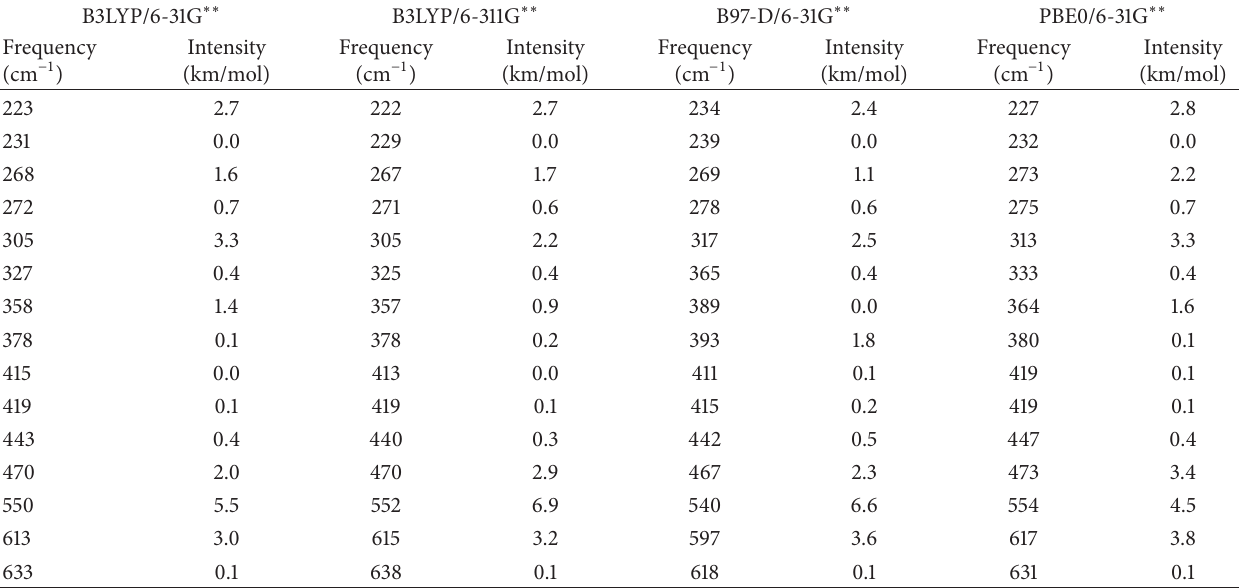
Table 3: Unscaled calculated frequency and intensity of the vibrations of DEBA in the frequency range between 150 and 670 cm −1 , with various levels of theory and basis